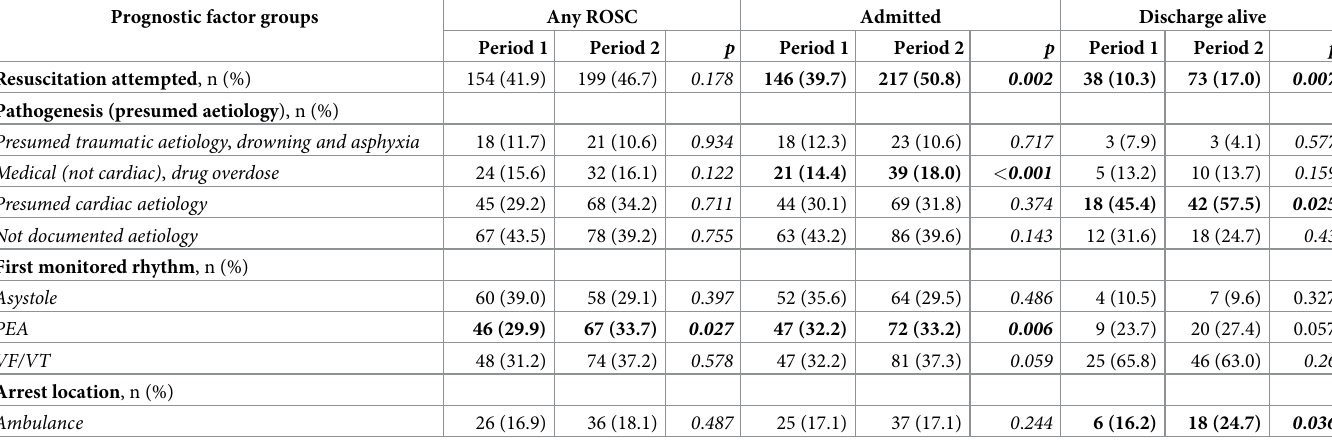
Table 3. Comparative outcomes for periods 1 and 2 (univariate